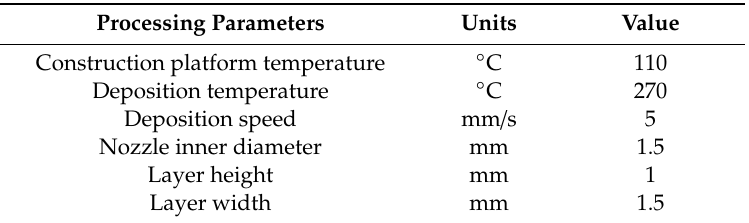
Table 2. Processing parameters.